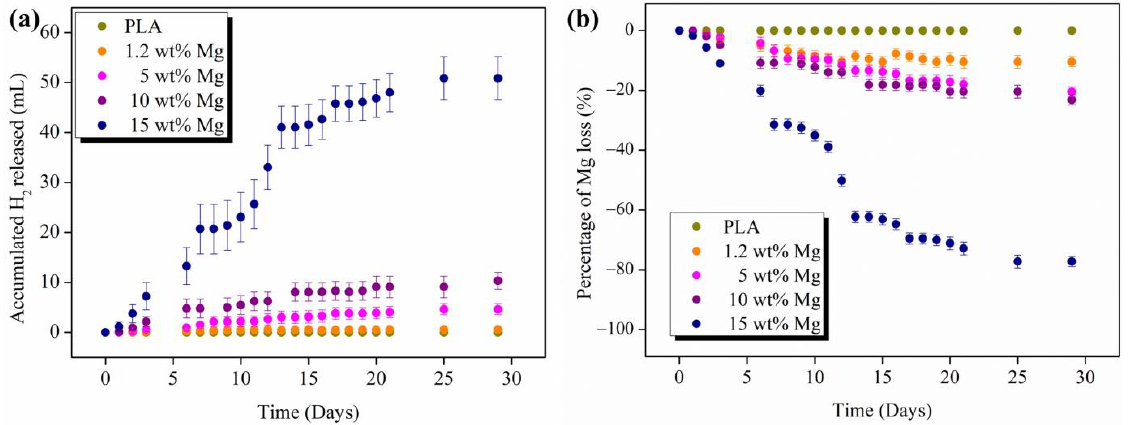
Figure 11. ( a ) Accumulated amount of hydrogen released as a function of immersion time in PBS and ( b ) Mg loss in terms of percentage of mass loss with respect to the Mg initial weight as a function of immersion time in PBS. of immersion time in